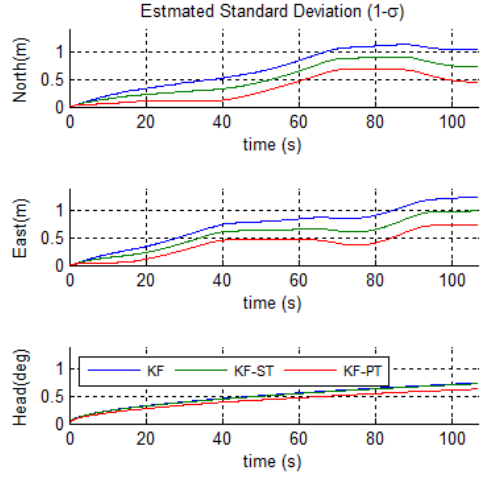
Figure 6. Estimated Position and Heading Standard